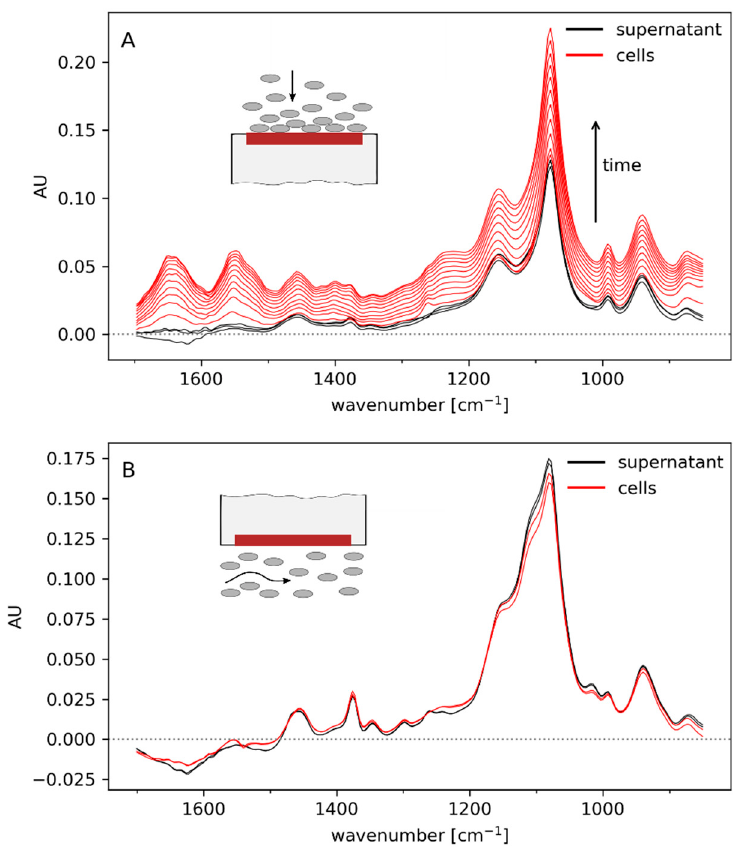
Figure 2. Off-line spectra of cells settling on the sensor ( A ) and in a stirred cell suspension ( B ). Cells were suspended in exhausted culture medium, and cell dry weight was 29 g/L. Water was subtracted as background.